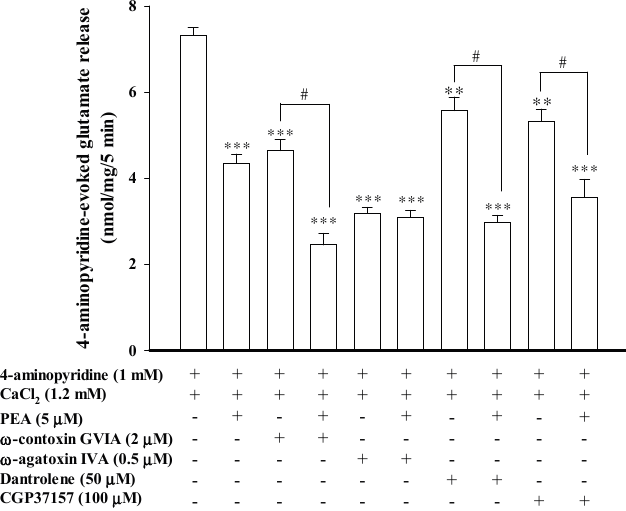
Figure 4. Blockade of Ca v 2.1 (P/Q-type) channels prevents the inhibitory effect of